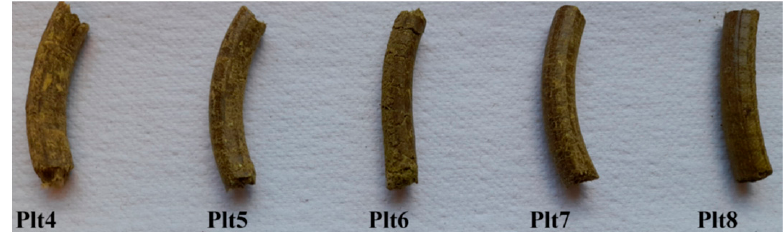
Figure 5. Five types of pellets composed of seaweed and wood chips. The physical properties of the eight types of pellets are presented in Table 2. In the last row of the table, the physical properties of standard wood pellets (ENplus A1, A2, & B) have been presented. CANplus and ENplus have the same specifications for wood pellets [15]. To measure the water content of each type of pellet, 10 g of each type was measured in the moisture analyzer. According to the data, all pellets have low water content roughly between 3 to 5 percent. By considering different ambient humidity during the pelletizing process and inevitable measurement errors, the 2% difference is justifiable. To measure the density and diameter of the pellets, three samples were selected, and their diameters were measured with a caliper vernier. By measuring the volume and mass of each sample, the density of each piece was calculated using Equation (1). For every pellet type, the average density of the three samples was added to the